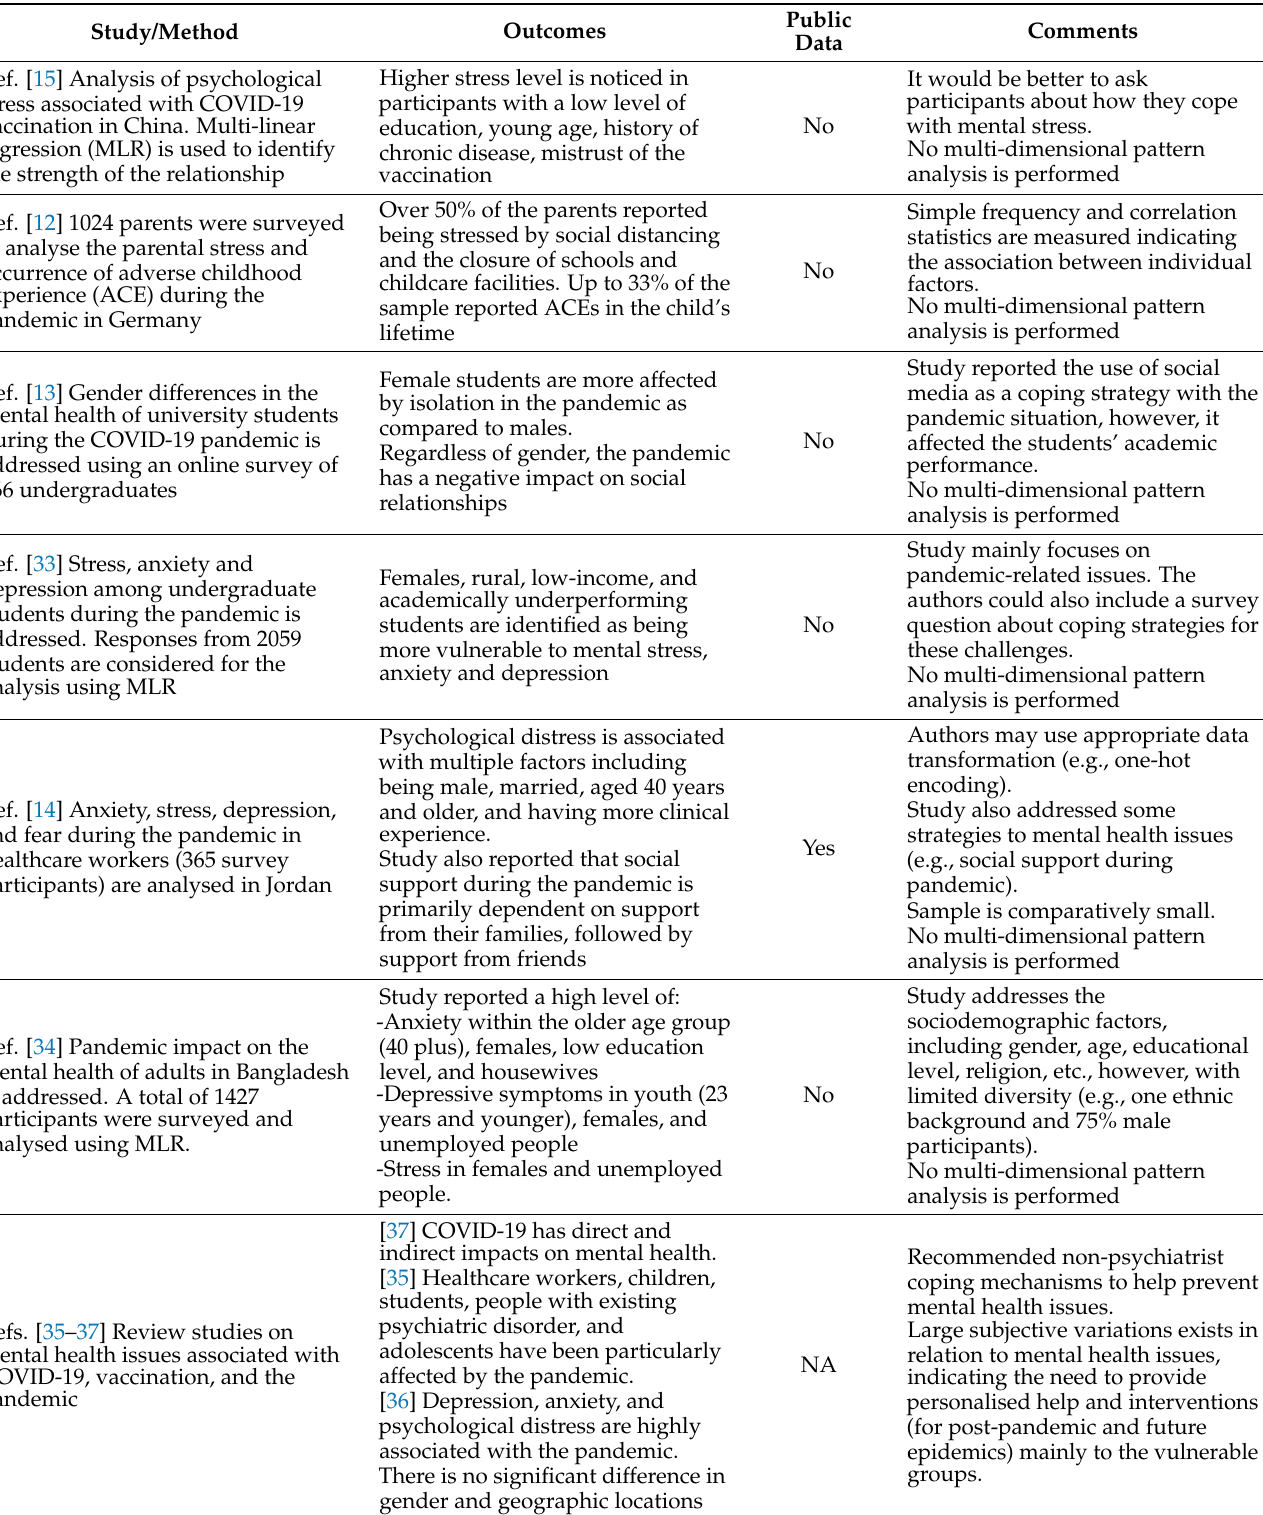
Table 1. Summary of recent works addressing the mental health problems associated with the COVID-19, pandemic and other related